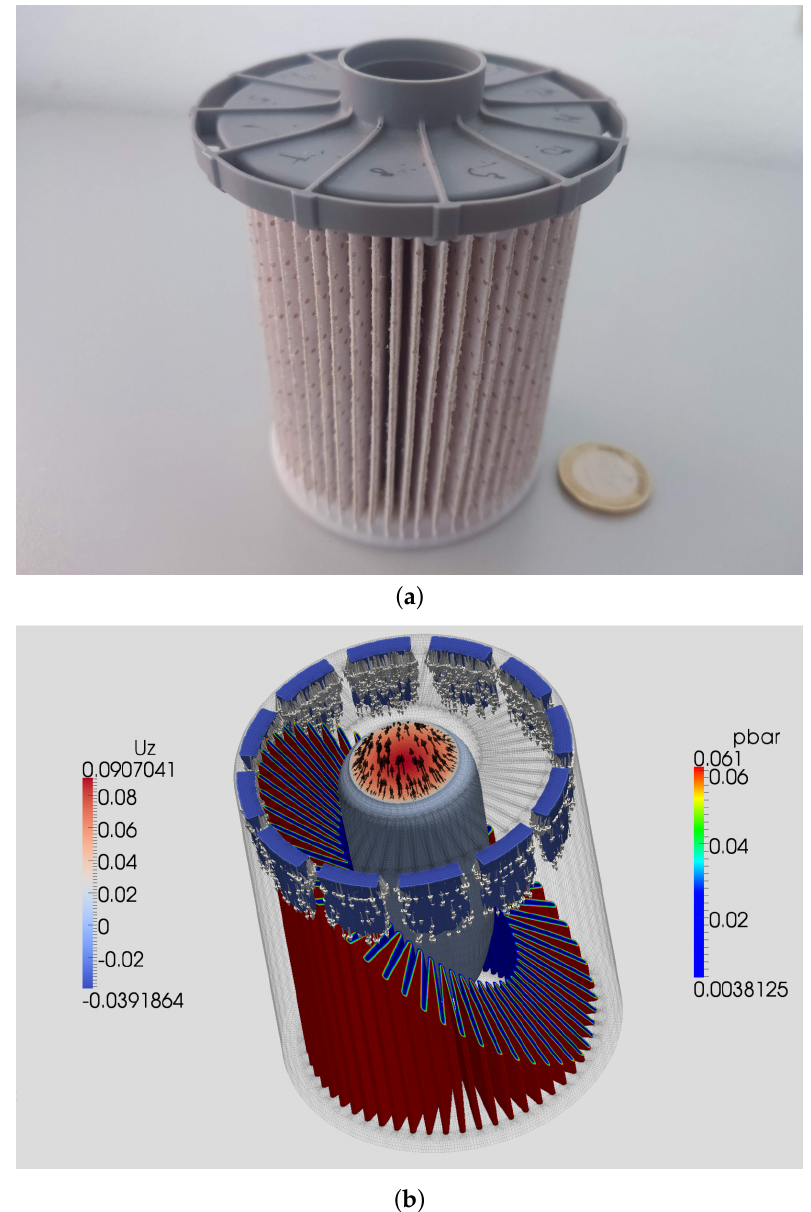
Figure 1. ( a ) Bosch filter device with the external holder removed to see the filtering medium. The flow enters vertically through the upper-side external slots and exits through the upper-side central duct; ( b ) 3.3 M cell mesh with pressure drop and velocity